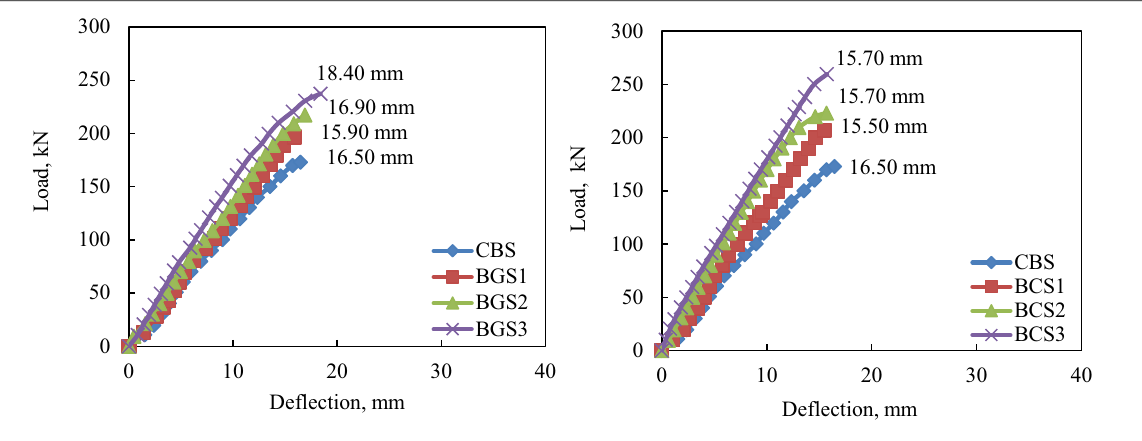
failure were below the strain at yielding point of steel.